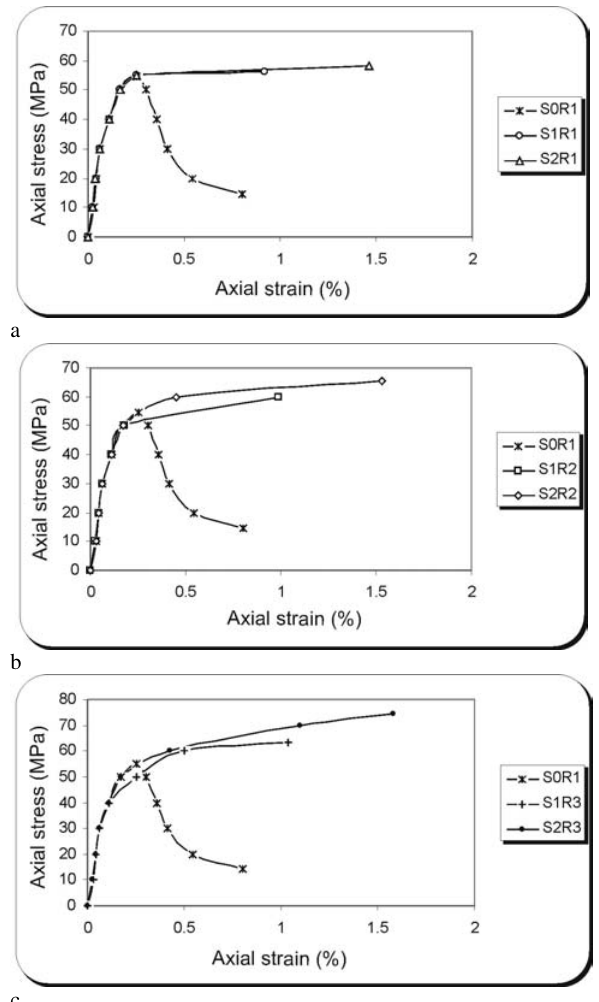
Fig. 6. Stress-strain curves of square prismatic specimens: a –R1 = 0 mm , b – R2 = 8 mm, c – R3 = 16